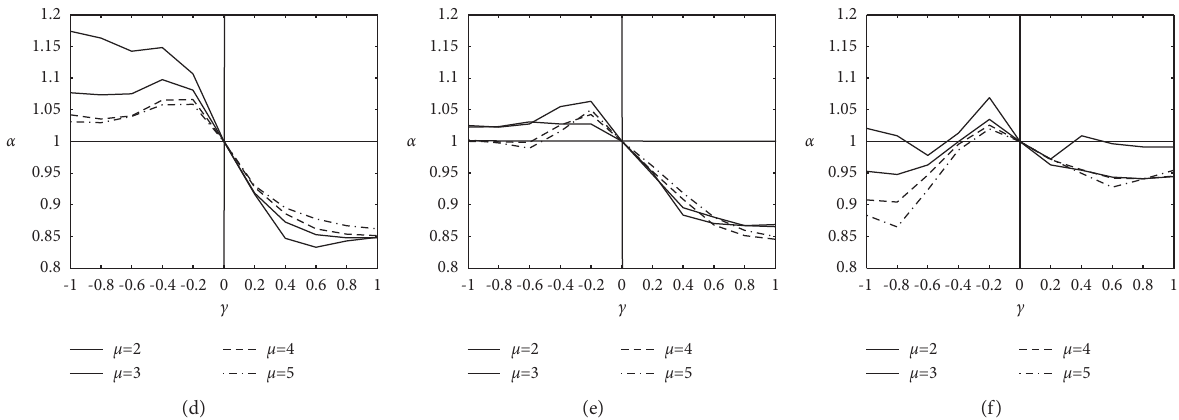
Figure 7: The curves of α of constant ductility factors for intermediate hard (soft) soil site. (a) T � 0–0.5 s. (b) T � 0.5–1.0s. (c) T � 1.0–2.0s. (d) T � 2.0–3.0s. (e) T � 3.0–4.0s. (f) T � 4.0–5.0s.